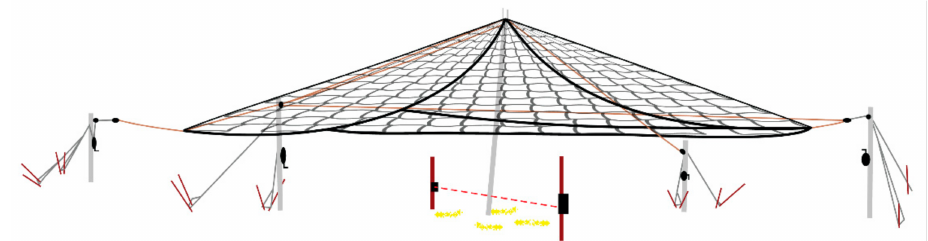
Figure 4. Drop net configuration including net (18.3 m (l) × 18.3 m (w)), center pole (6.1 m (h)), rope harnesses, support poles, deadmen anchors, infrared trail monitor, and bait placement used on